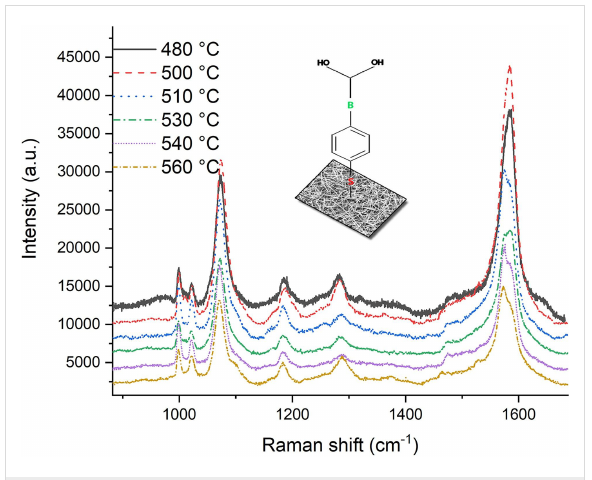
Figure 1: SERS spectra of 10 − 4 M 4-MPBA (inset) after immersion in H 2 O for different VLS process